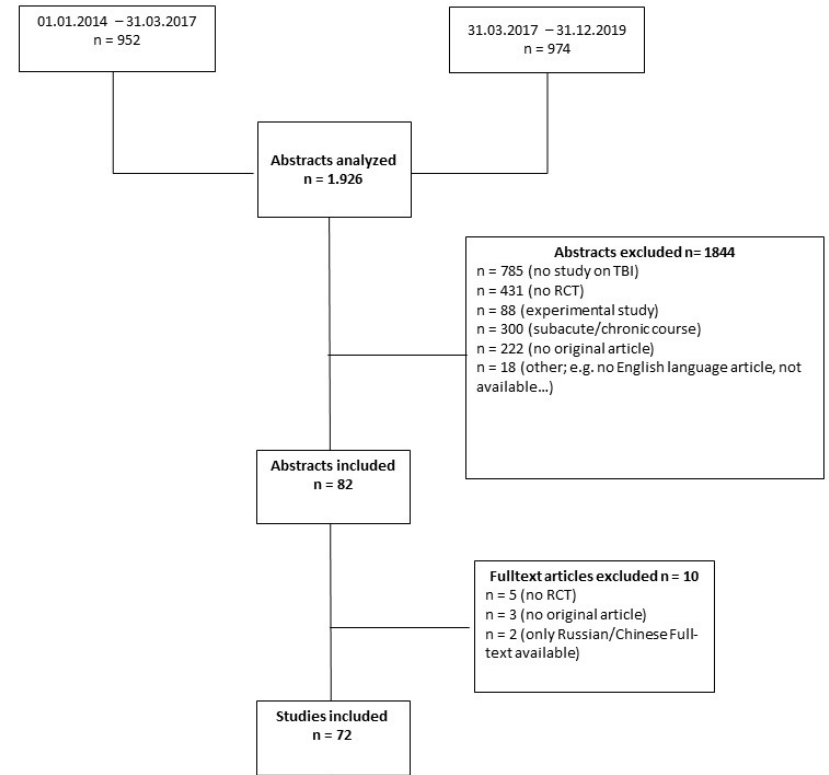
Figure 1. Flowchart of the studies included.